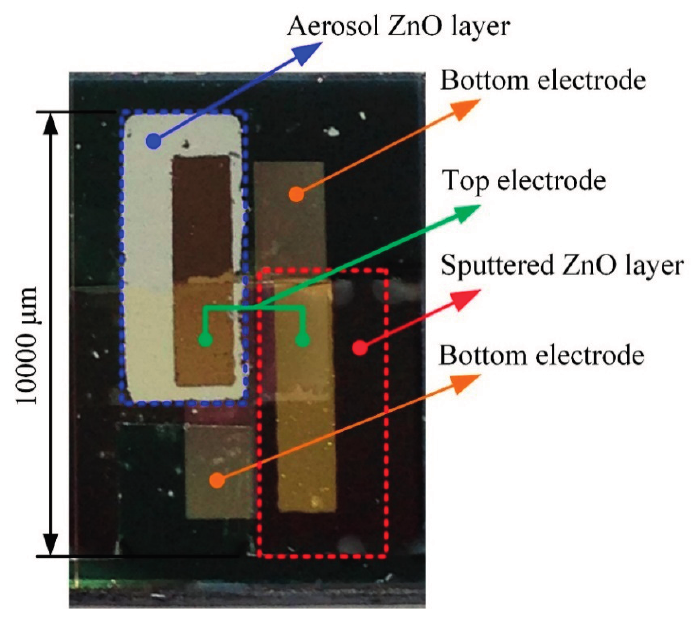
Figure 5. Fabricated multi-frequency band pyroelectric